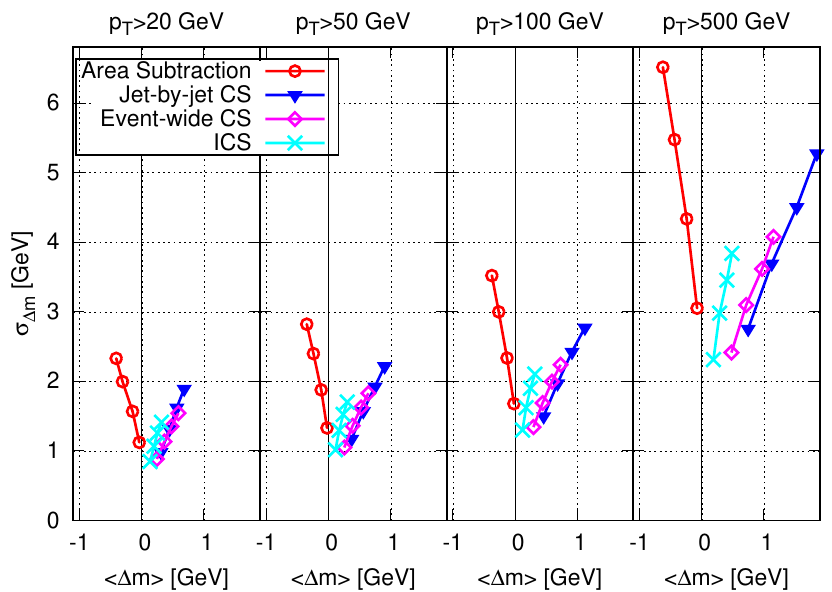
Figure 8. Comparison of the jet mass resolution as a function of jet mass bias for the Area Subtraction, jet-by-jet CS, Event-wide CS and ICS methods. Dijet events are used with di(cid:11)erent jet p T cut in each panel. Each curve corresponds to a di(cid:11)erent method and the 4 points on each curve correspond to N PU = 30, 60, 100 and 140 from bottom to top.